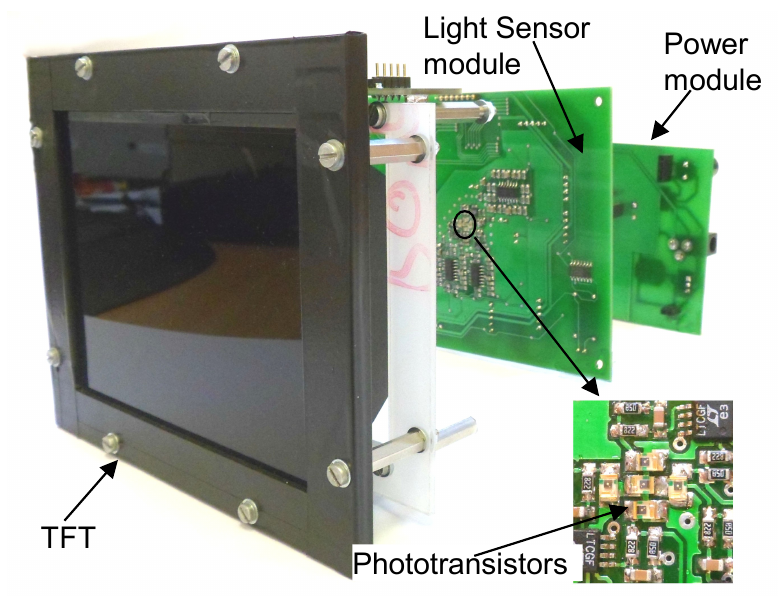
Figure 12. Explode view of the